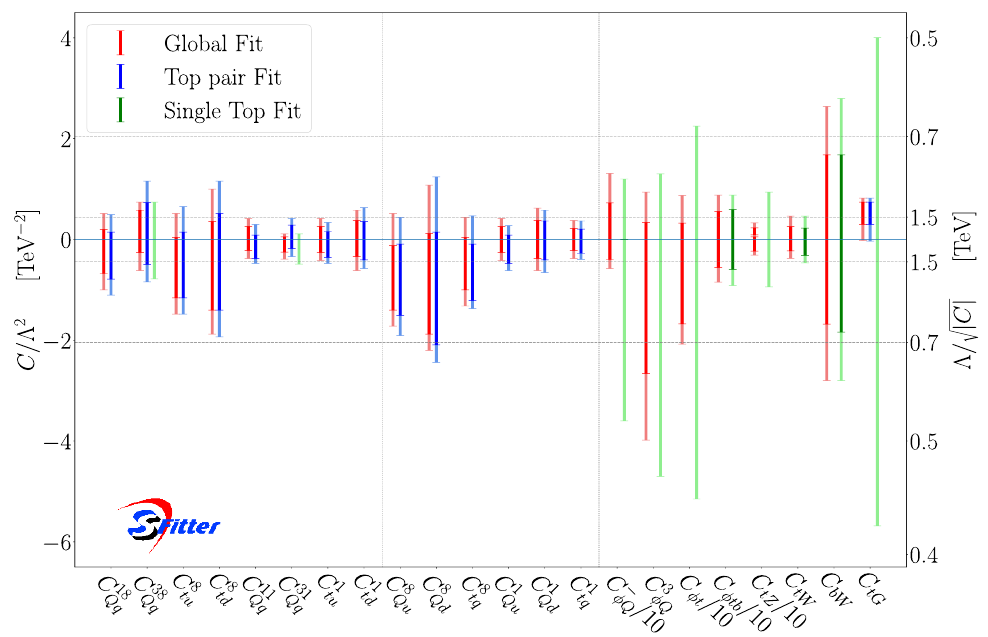
Figure 14 . 95% and 68% CL bounds on top operators global (cid:12)ts to top pair production measure- ments (blue), single top (green) and to the full data set from tables 5 and 6